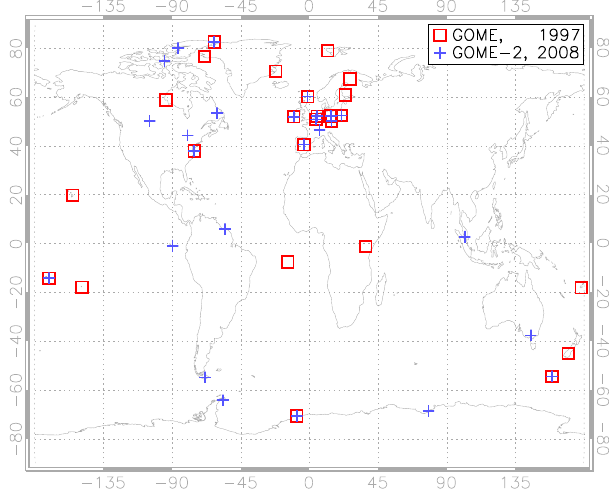
Fig. 2. The locations of the ozone sonde stations used for the val- idation of GOME (1997, red squares) and GOME-2 (2008, blue crosses).